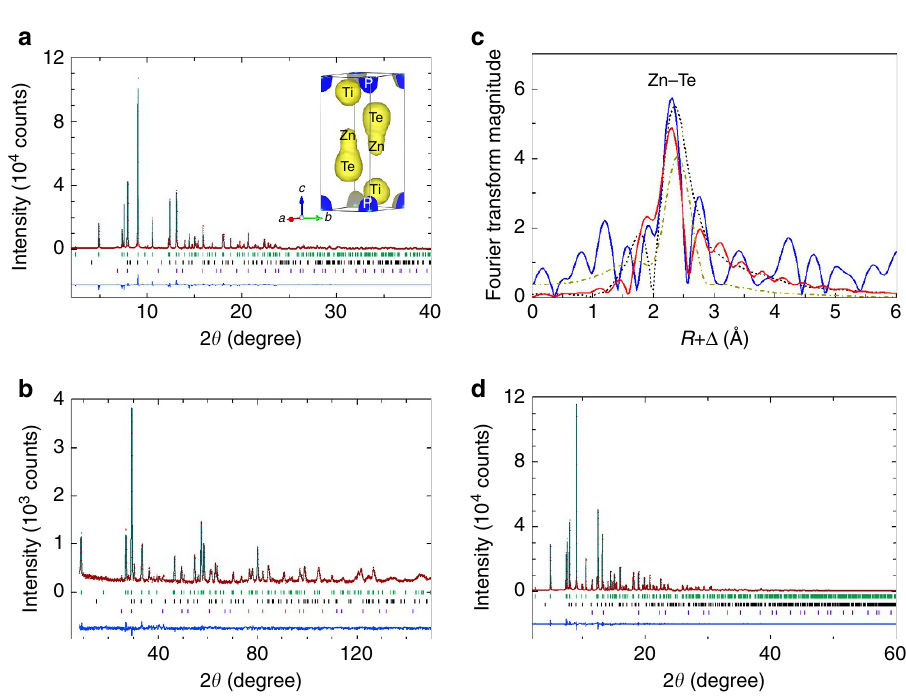
Figure 3 | Structural refinement for M x Ti 2 PTe 2 ( M ¼ Zn, Cu). Refined ( a ) Synchrotron X-ray diffraction and ( b ) neutron diffraction patterns of Zn 0.4 Ti 2 PTe 2 , showing observed (red), calculated (green) and difference (blue) profiles. The upper, middle and lower ticks represent the positions of the calculated Bragg reflections of Zn 0.4 Ti 2 PTe 2 , TiP and ZnTe, respectively. Inset of a shows the result of MEM analysis, where a strong Zn–Te bond along the c axis was observed. ( c ) Fourier transforms of the extended X-ray absorption fine structure (EXAFS) spectrum (blue) at the Zn K-edge of Zn 0.4 Ti 2 PTe 2 , which is compared with calculated Fourier transforms of (red) the anisotropic tetrahedron based on the neutron diffraction refined crystal structure, (dotted line) the equidistant tetrahedron and (dashed line) octahedron. ( d ) Refined synchrotron X-ray diffraction pattern of Cu 0.28 Ti 2 PTe 2 . The upper, middle and lower ticks represent the positions of the calculated Bragg reflections of Cu 0.28 Ti 2 PTe 2 , TiP and Cu,